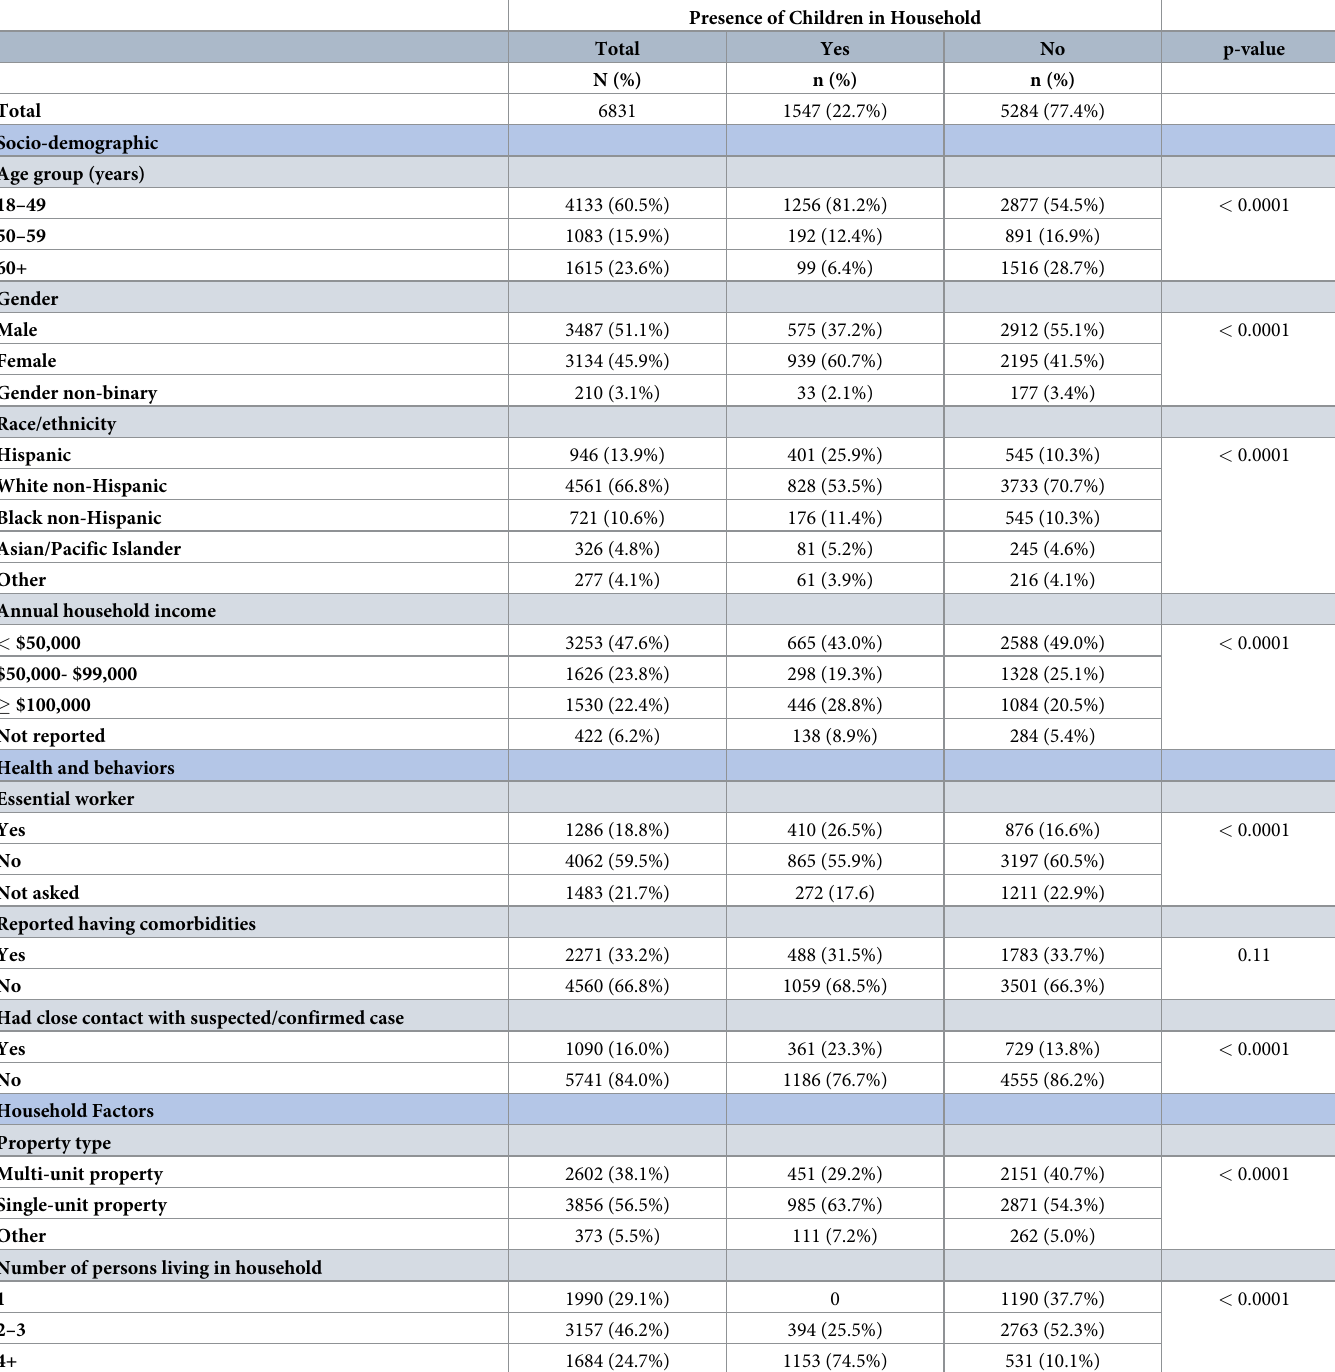
Table 1. Select socio-demographic, health and behavior characteristics among persons screened for enrollment in the CHASING COVID Cohort (N = 6831), April